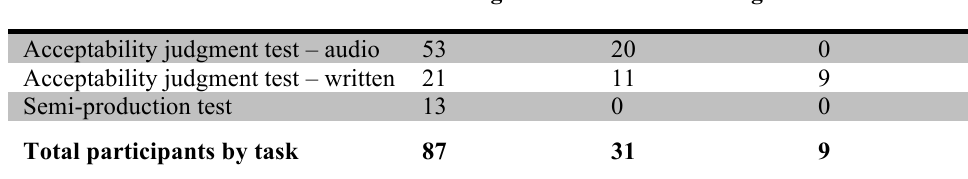
Table 2: Total number of participants by data collection